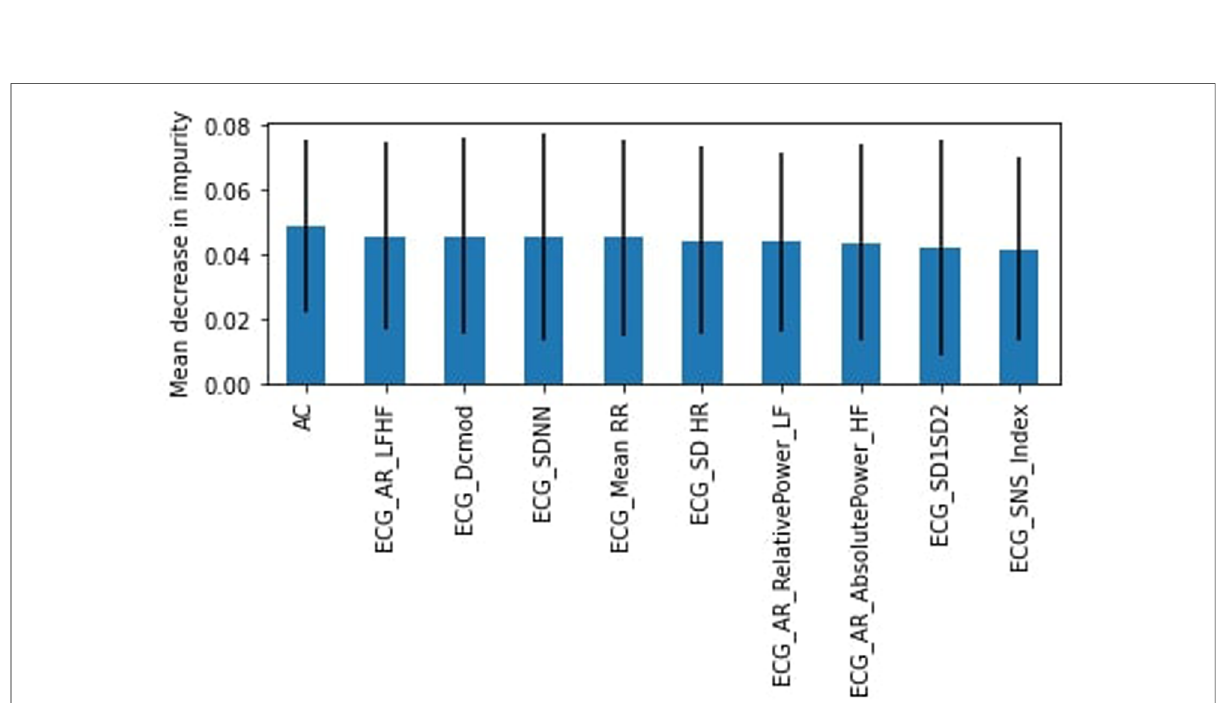
FIGURE 7 RF feature importance, subjects aged 35 –